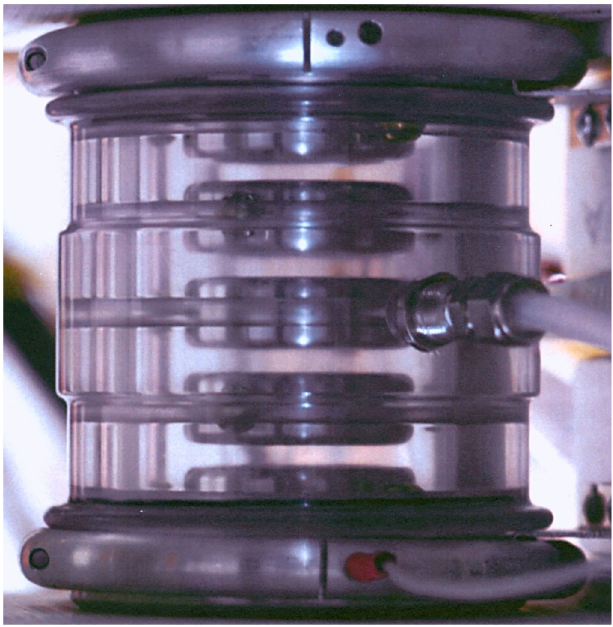
FIG. 6. (Color) Photograph of the LTD cavity switch. The voltage grating electrodes of the switch can be seen as well as one of the gas switch input connected to the center